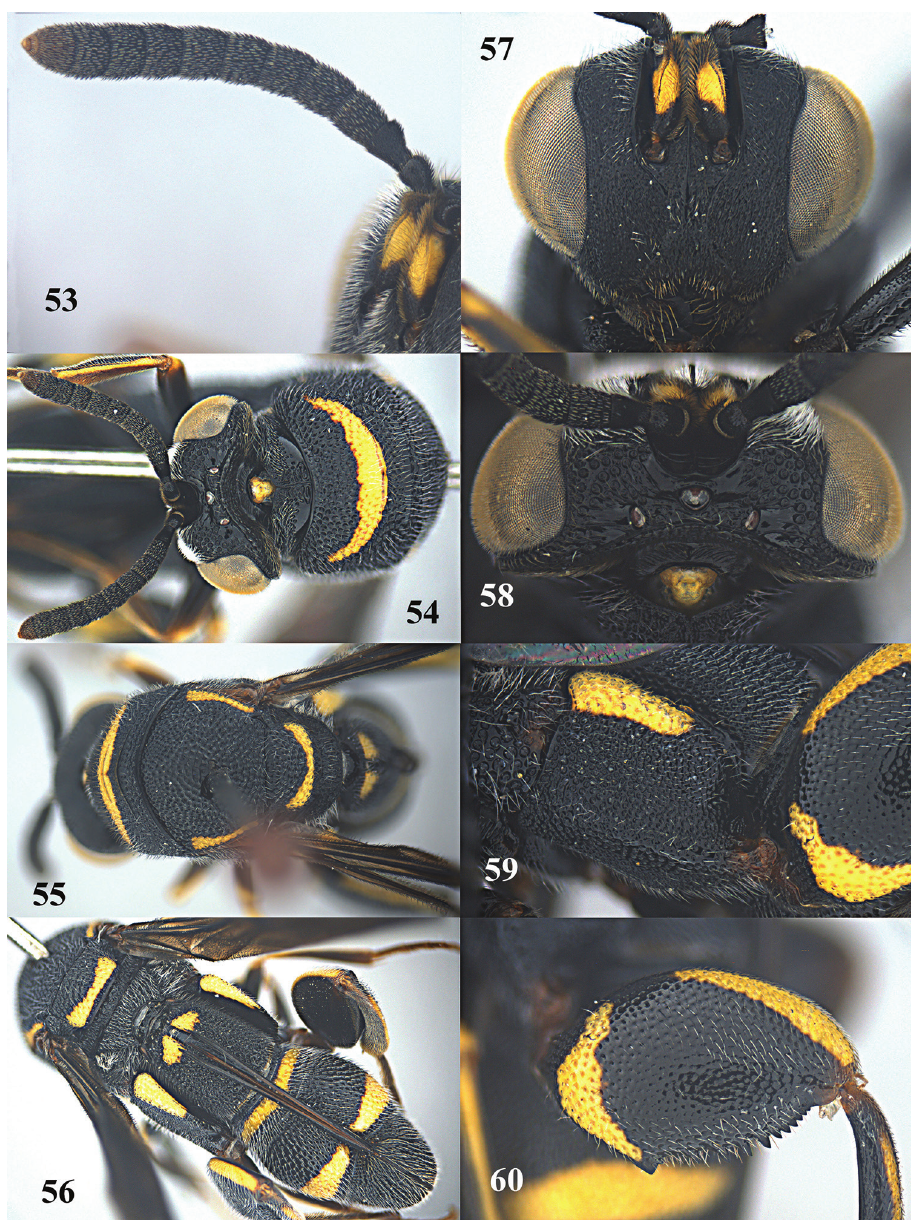
Figures 53–60. Leucospis femoricincta Bouček, ♀ from Guangdong, Yingxifenglin. 53 Antenna 54 head and pronotum dorsal 55 mesosoma dorsal 56 propodeum and metasoma dorsal 57 head frontal 58 head dorsal 59 hind coxa 60 hind